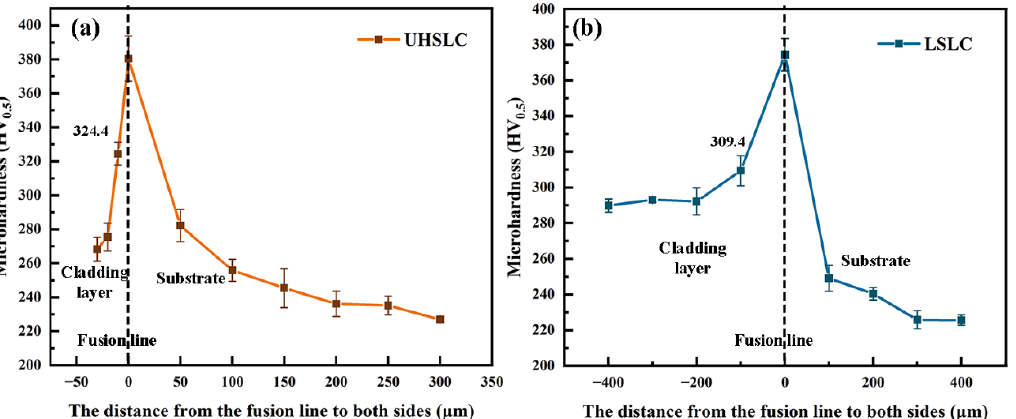
Figure 10. Cross-sectional microhardness distribution of Inconel625 alloys coatings: ( a ) under UHSLC; ( b ) under LSLC.